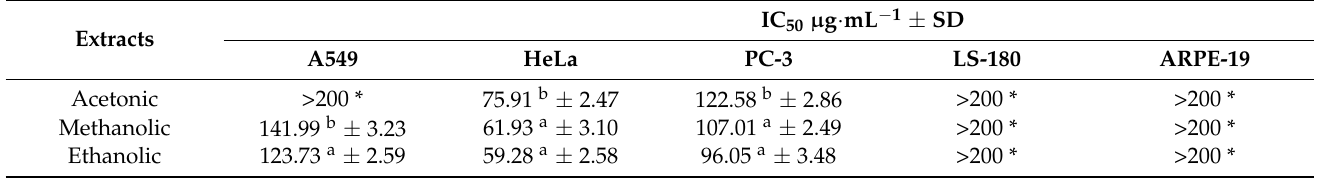
Table 9. Antiproliferative activity (IC 50 values) of extracts from N. incerta on human cell lines.